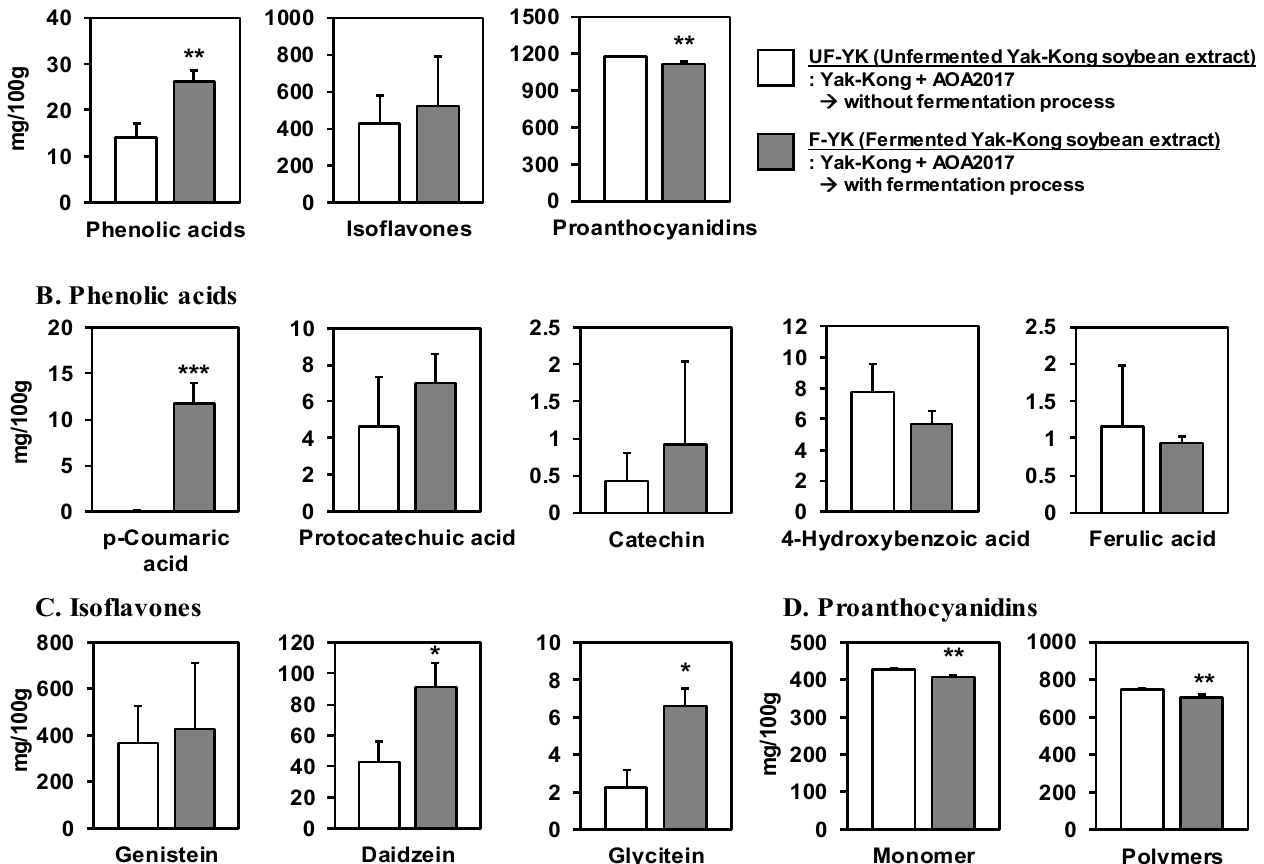
Figure 2. Effect of fermentation using P. pentosaceus AOA2017 on the content of polyphenols in YK. ( A ) Total content of phenolic acids, isoflavones, and proanthocyanidins in unfermented and fermented YK extract. The content of the major compounds were measured using ( B ) UHPLC-MS / MS, ( C ) UHPLC-PDA, and ( D ) HPLC-fluorescence analysis, respectively. Data are expressed as mean ± SD ( n = 3). Student’s t -test was used for statistical analysis between UF-YK and F-YK; *** p < 0.001, ** p < 0.01, * p < 0.05. UF-YK, unfermented Yak-Kong extract; F-YK, Yak-Kong extract fermented with P. pentosaceus AOA2017.